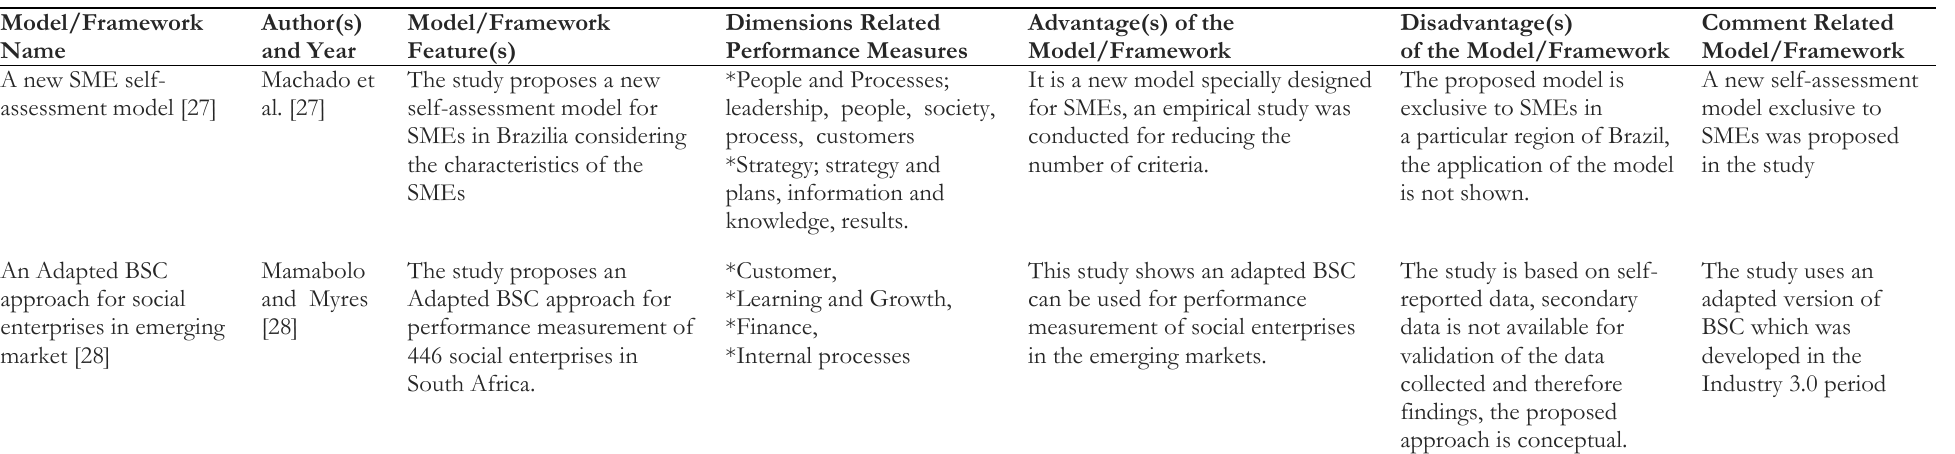
Table 8. Organizational performance measurement models developed in Industry